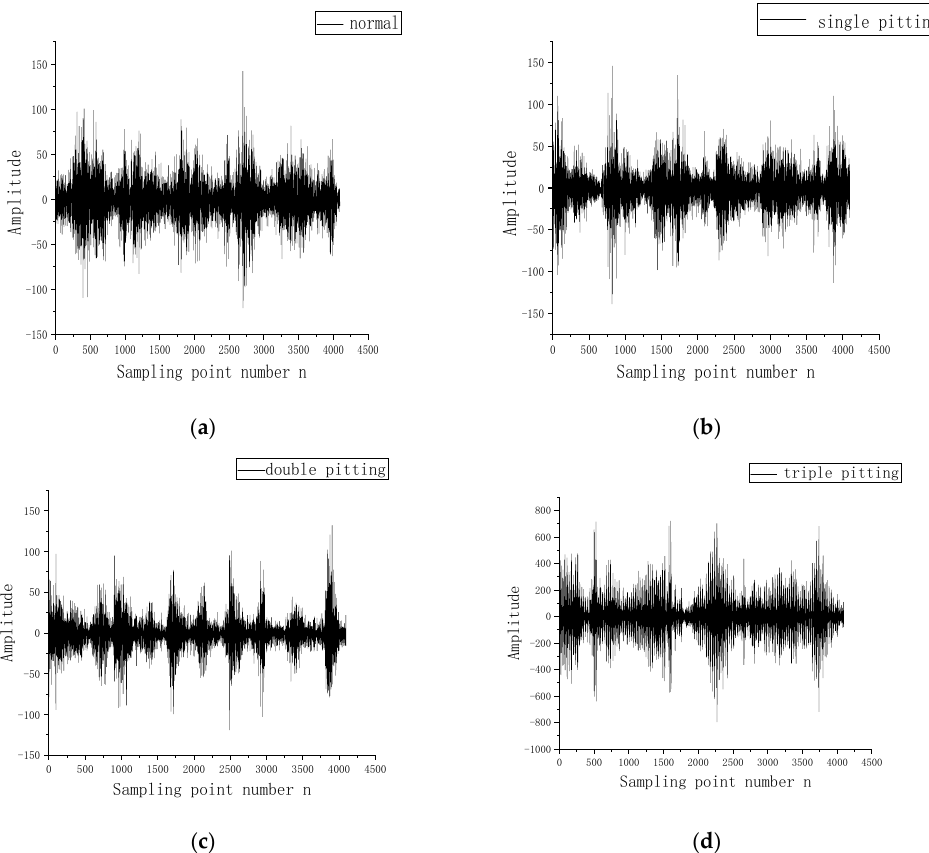
Figure 13. Vibration signals for 4 types of gear health monitoring. ( a ) Normal condition, ( b ) single pitting condition, ( c ) double pitting condition, ( d ) triple pitting condition. Table 6. BP algorithm experimental test